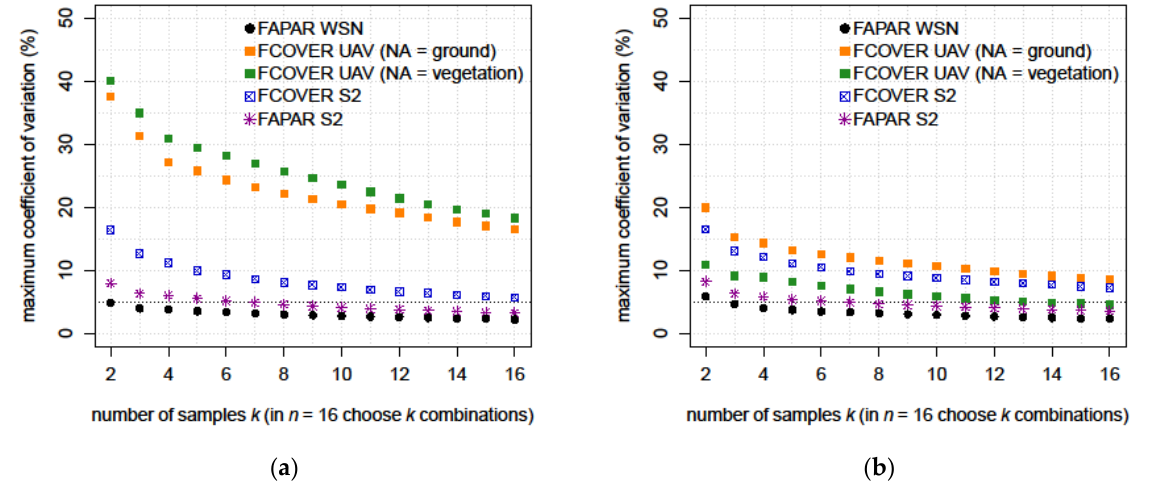
Figure 12. Spatial variability of FAPAR and FCOVER products shown as the maximum coefficient of variation in percent as a function of the number of samples at the ( a ) spring and ( b ) summer acquisition dates. The dashed line at 5% refers to the minimum uncertainty accepted by the GCOS for FAPAR products.